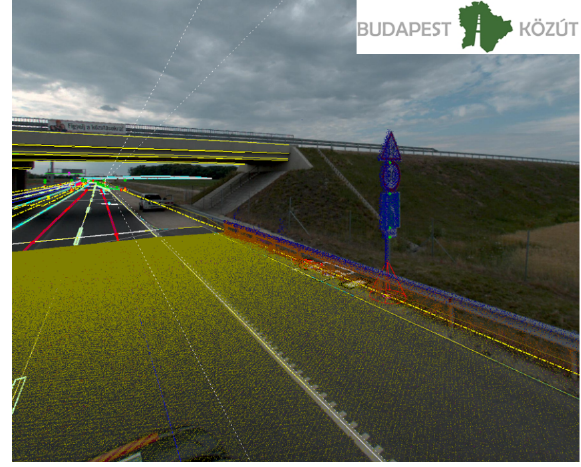
Figure 6. Three-dimensional (3D) point clouds and camera picture with 3D vectors.